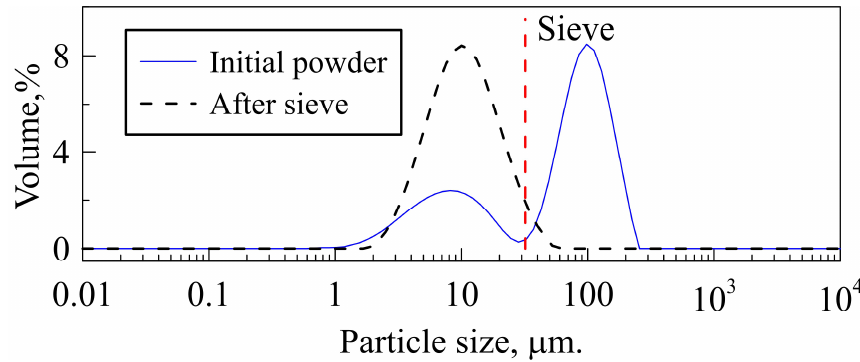
Figure 5. Particle size distribution in HVA powder with sieve mesh marked.